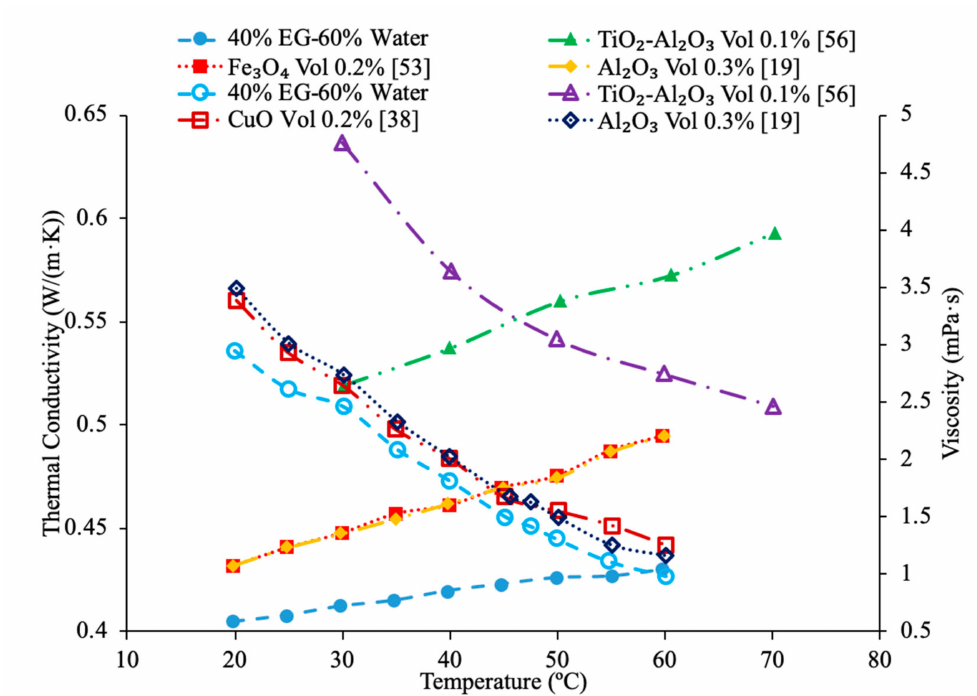
Figure 17. Thermal conductivity (increasing with temperature) and viscosity (decreasing with